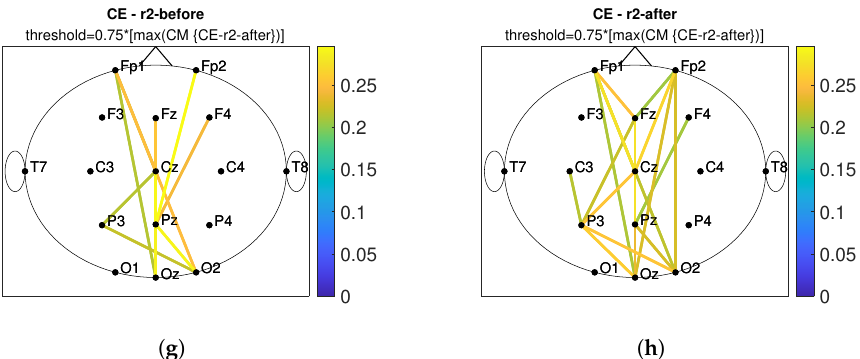
Figure 12. The short-term effect of PBM stimulation in observing the connectivity values of imCPCC at the r 2. The connectivity matrices ( CM ) and the head plot of the connections above threshold between electrode pairs are observed. ( a ) shows the CM under the OE condition before stimulation and ( c ) shows the headplot of the connections, while ( b , d ) show the CM and the headplot of the connections after stimulation. ( e – h ) show the CM or the headplot of the CE condition.